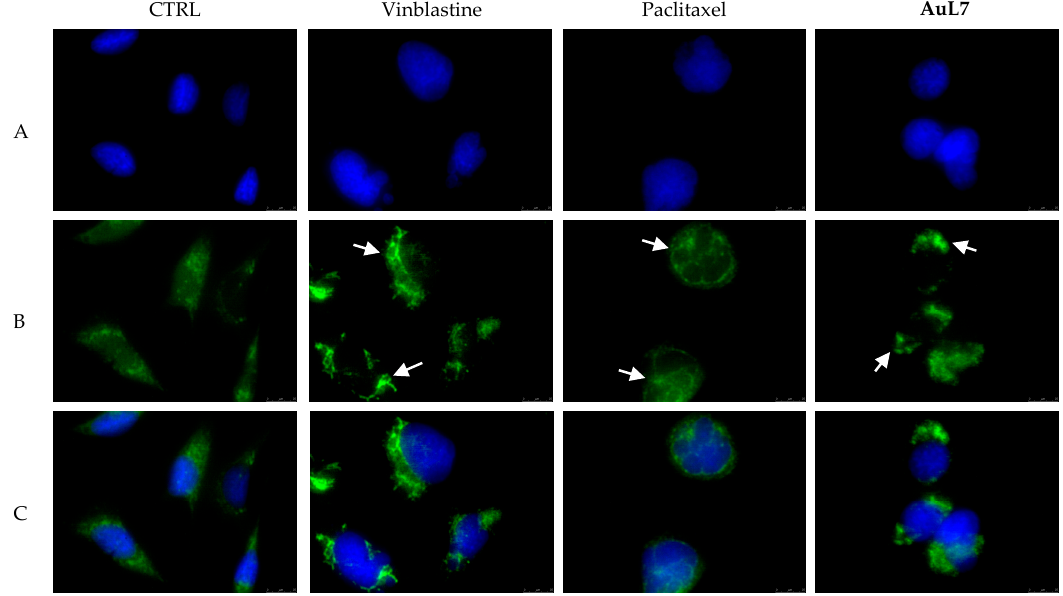
Figure 5. Immunofluorescence studies. MDA-MB-231 cells were treated with AuL7 , Vinblastine, Paclitaxel (used at their IC 50 values) or with a vehicle (CTRL) for 24 h. After treatment, the cells were methanol fixed, incubated with primary and secondary antibodies, stained with 4 ′ ,6-diamidino-2-phenylindole (DAPI) and observed and imaged under the inverted fluorescence microscope at 63× magnification (see Materials and methods). Vehicle-treated cells (CTRL) exhibited a normal arrangement and organization of the cytoskeleton. Microtubules of MDA-MB-231 cells treated with vinblastine and paclitaxel showed an irregular arrangement and organization: particularly, tubulin crystal formation (white arrows, panel B , vinblastine) and tubulin bundles and thicken fibers (white arrows, panel B , paclitaxel) can be noted for vinblastine and paclitaxel respectively. Treatment with AuL7 shows a vinblastine-like mode of action (white arrows, panels B , AuL7 ). Panels A : DAPI, excitation / emission wavelength 350 nm / 460 nm; panels B : β -tubulin (Alexa Fluor ® 488) excitation / emission wavelength 490 nm / 515 nm; panels C show a merge. Representative fields are shown.